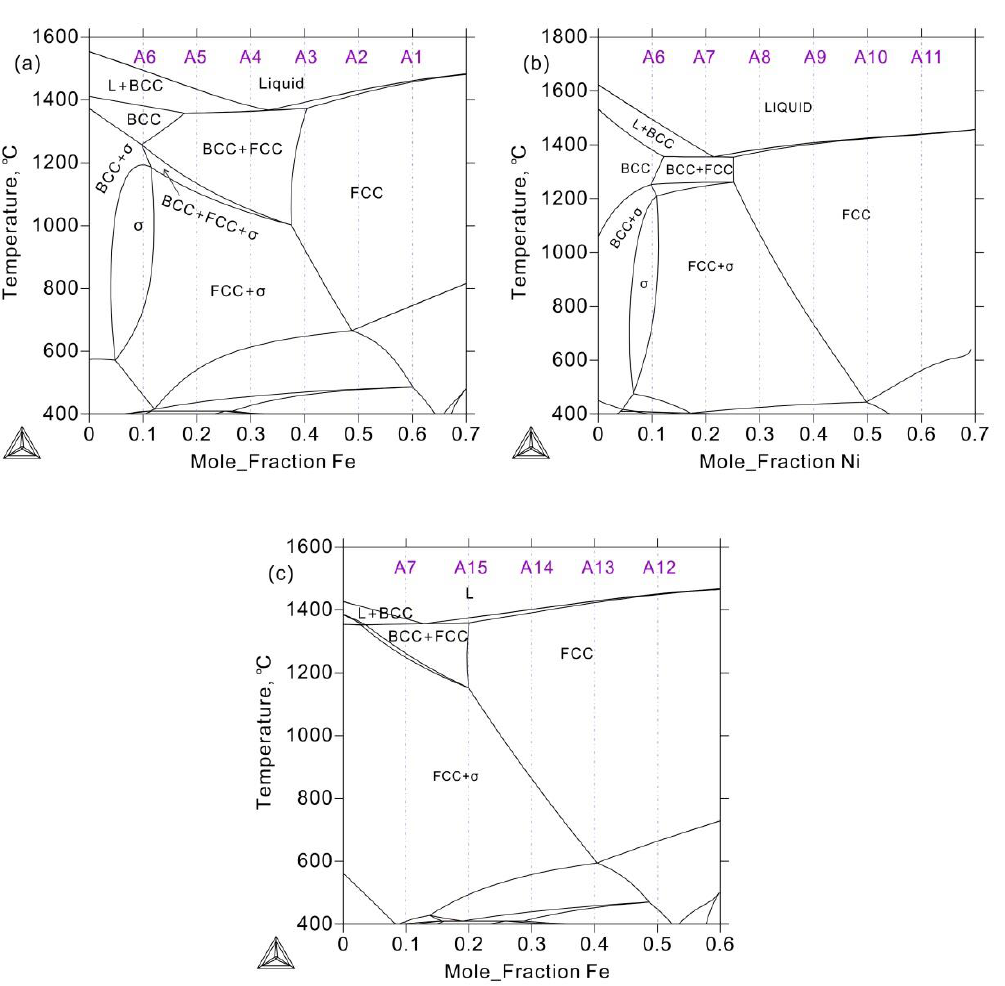
Figure 3. The vertical sections of the Co-Cr-Fe-Ni system calculated with the TCFE thermodynamic database. ( a ) fixed 20 at.%Co and 10 at.%Ni, ( b ) fixed 20 at.%Co and 10 at.%Fe, ( c ) fixed 20 at.%Co and 20 at.%Ni.